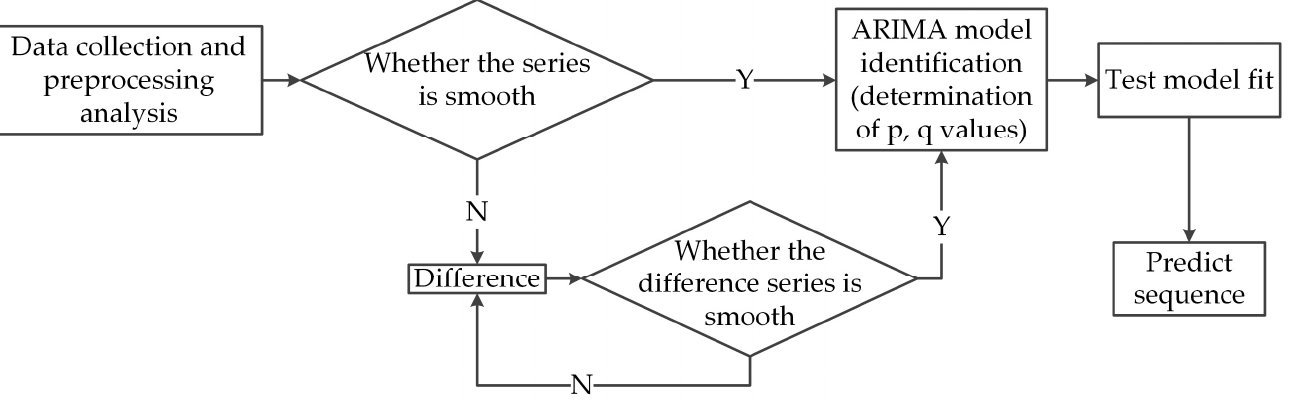
Figure 4. The ARIMA modeling